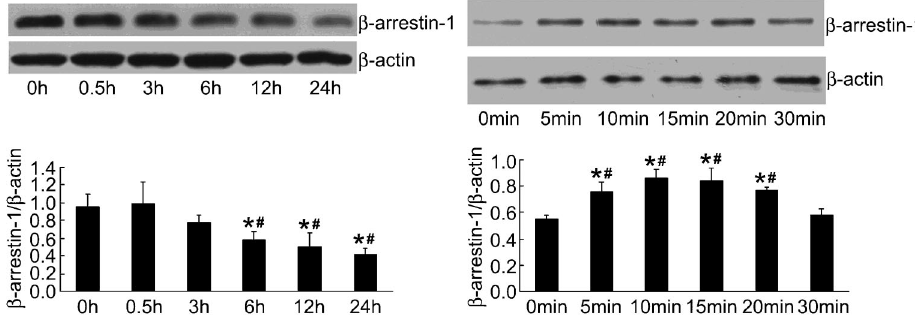
Figure 5. Effect of penehyclidine hydrochloride (PHC) on b -arrestin-1 expression with time in lipopolysaccharide (LPS)-induced human pulmonary microvascular endothelial cells (HPMEC) (n=3). HPMEC were pre-incubated with 2 m g/mL PHC for 1 h and treated with 0.1 m g/mL LPS for different times. This figure is representative of the experiment. b -arrestin-1 protein expression is reported as respective absorbance/ b -actin absorbance. b -arrestin-1 had the highest expression at 10 and 15 min. *P , 0.01, compared with 0 h; # P , 0.01, compared with 0.5 h; *P , 0.01, compared with 0 min; # P , 0.01, compared with 30 min (ANOVA).